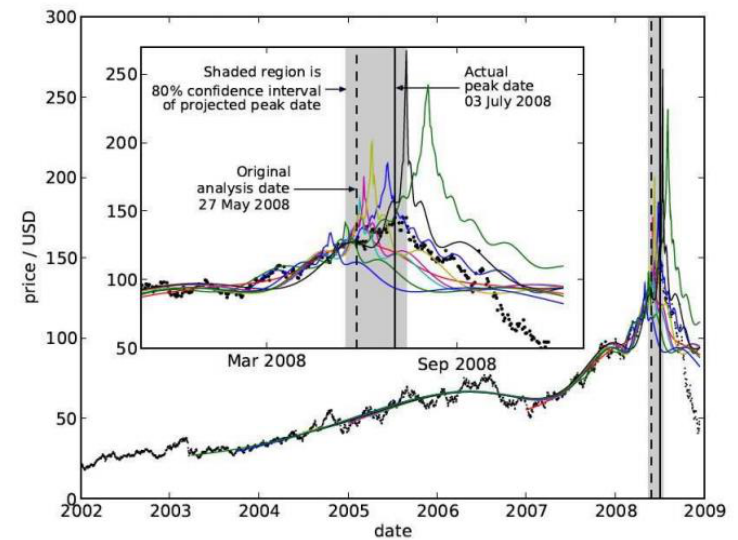
Figure 14. The historical evolution of oil prices shown as dots (from [19]). The dashed vertical line shows the last observation used to calibrate our model. The colored curves show different fits. The inset shows a magnification around the time of the peak. As in Figure 13, it is expected that the correction occurs with 80% probability in the grey shaded